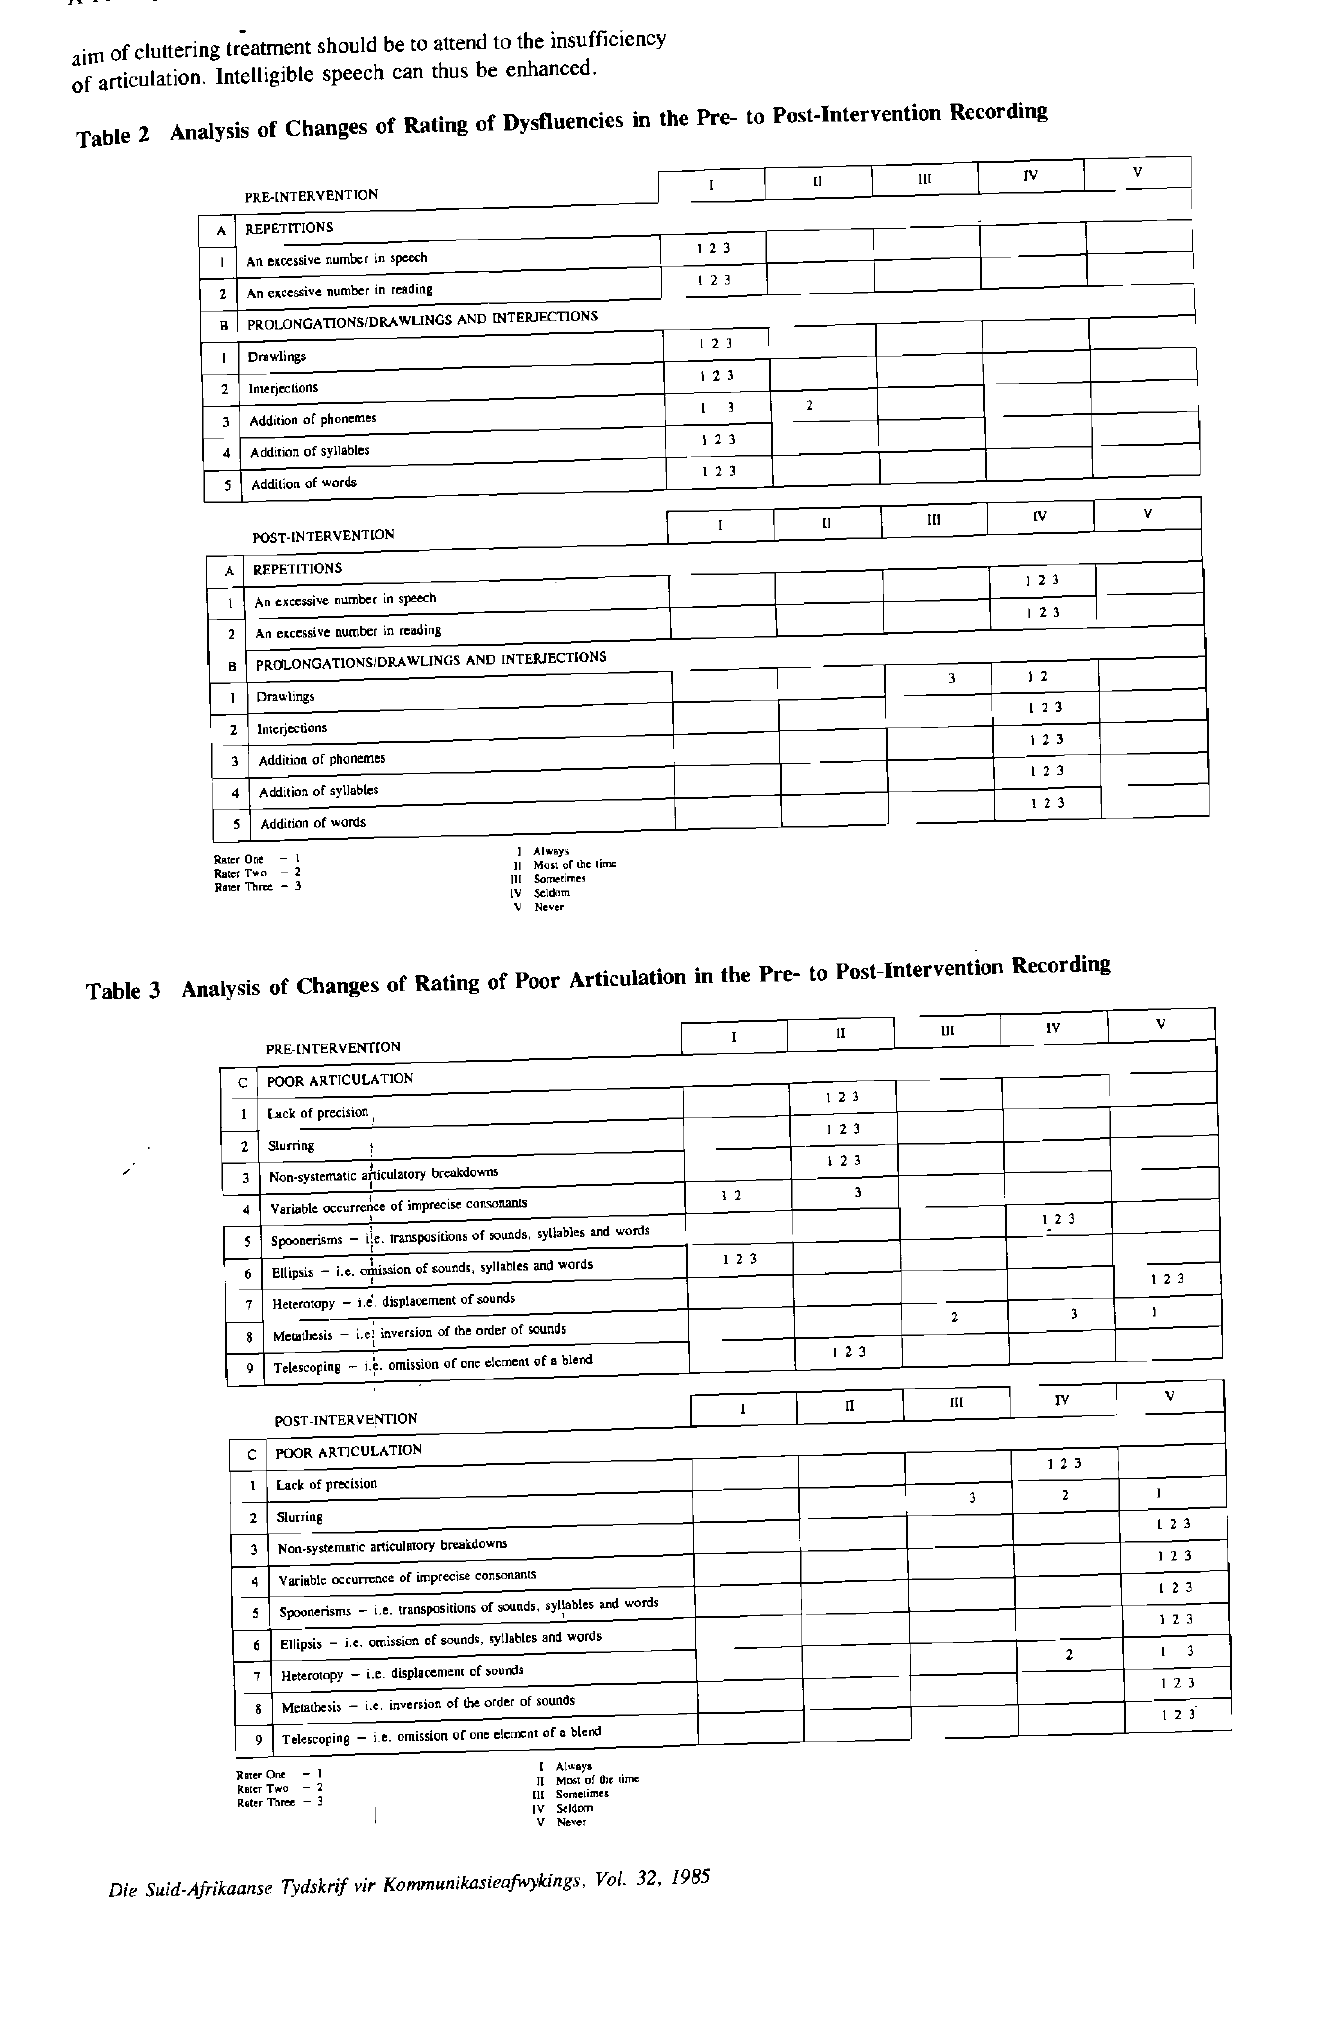
Table 2 Analysis of Changes of Rating of Dysfluencies in the Pre- to Post-Intervention Recording